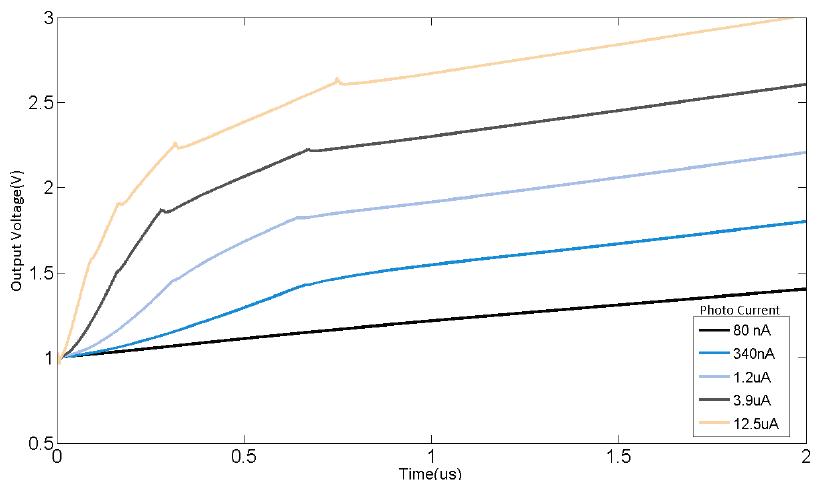
Figure 14. The transient simulation of the pixel integration.